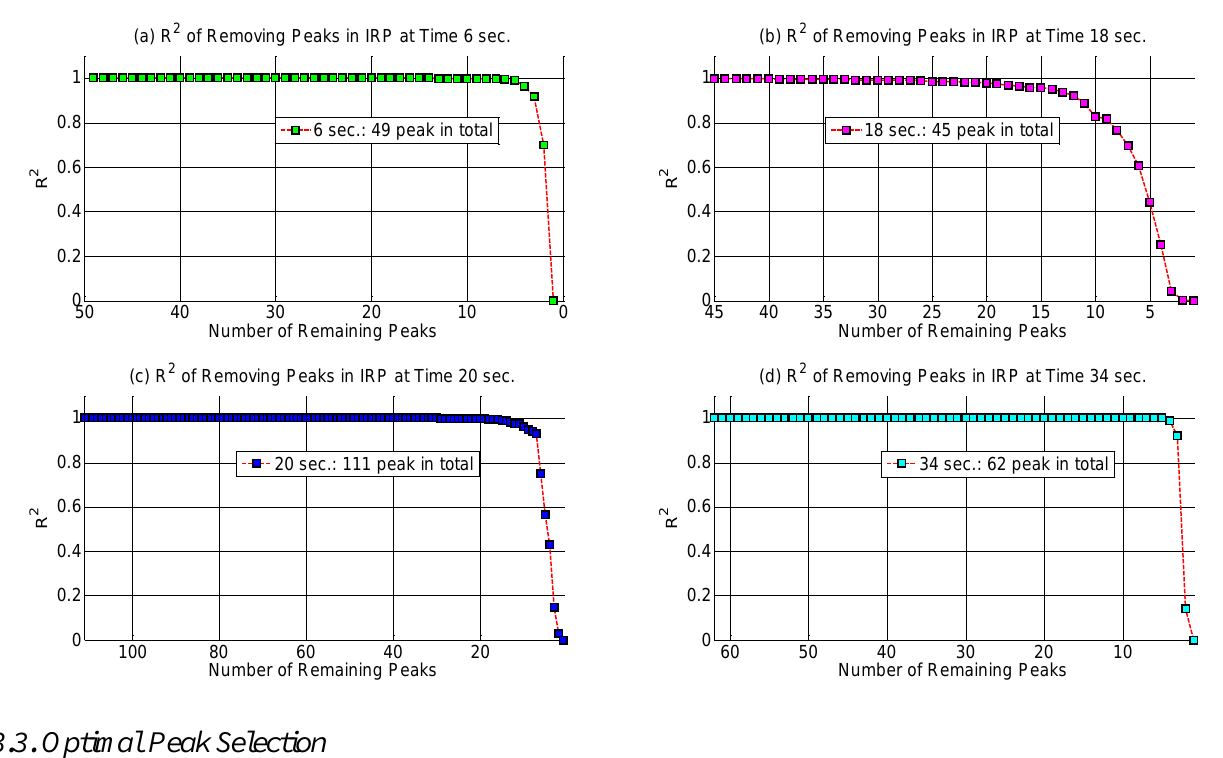
Figure 2. R 2 values of regression of the remaining peaks in the pool on the peak to be removed in each IRP iteration ( a ) at time 6 s, ( b ) at time 18 s, ( c ) at time 20 s, and ( d ) at time 34 s, as a function of remaining number of peaks in